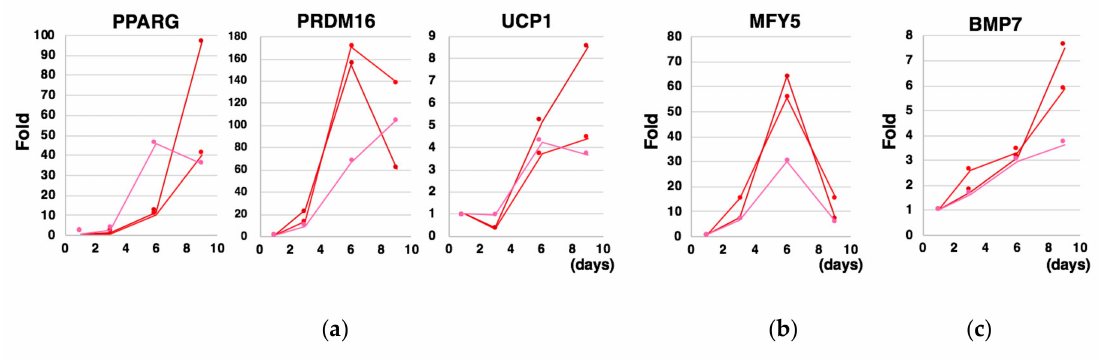
Figure 5. Kinetics of gene expressions during the di ff erentiation into BA under a cytokine-free condition. Three independent experiments were performed. The expressions of BA marker genes ( a ), a marker for a BA progenitor ( MYF5 ) ( b ), a gene that is required for BAT genesis ( BMP7 ) ( c ) were examined at Day 1, Day 3, Day 6, Day